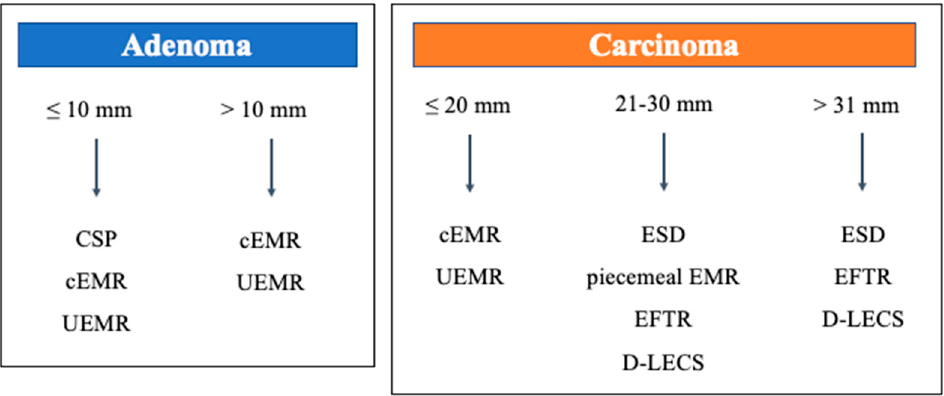
Figure 1. Our current strategy recommendation for SNADETs. cEMR: conventional endoscopic mucosal resection, CSP: cold snare polypectomy, D-LECS: laparoscopic and endoscopic cooperative surgery for duodenal tumors, EFTR: endoscopic full thickness resection, ESD: endoscopic submucosal dissection, SNADET: superficial non-ampullary duodenal epithelial tumors, UEMR: underwater endoscopic mucosal resection.